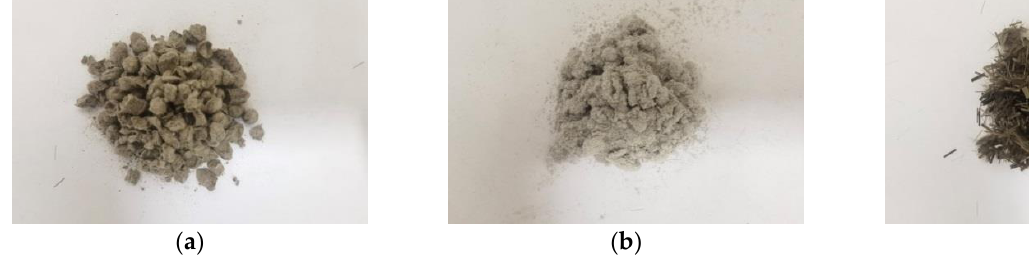
Figure 1. Macro morphology of fiber: ( a ) Granular lignin fiber; ( b ) Flocculent; ( c ) Basalt fiber. Table 2. Performance of fibers (offered by manufacturers).